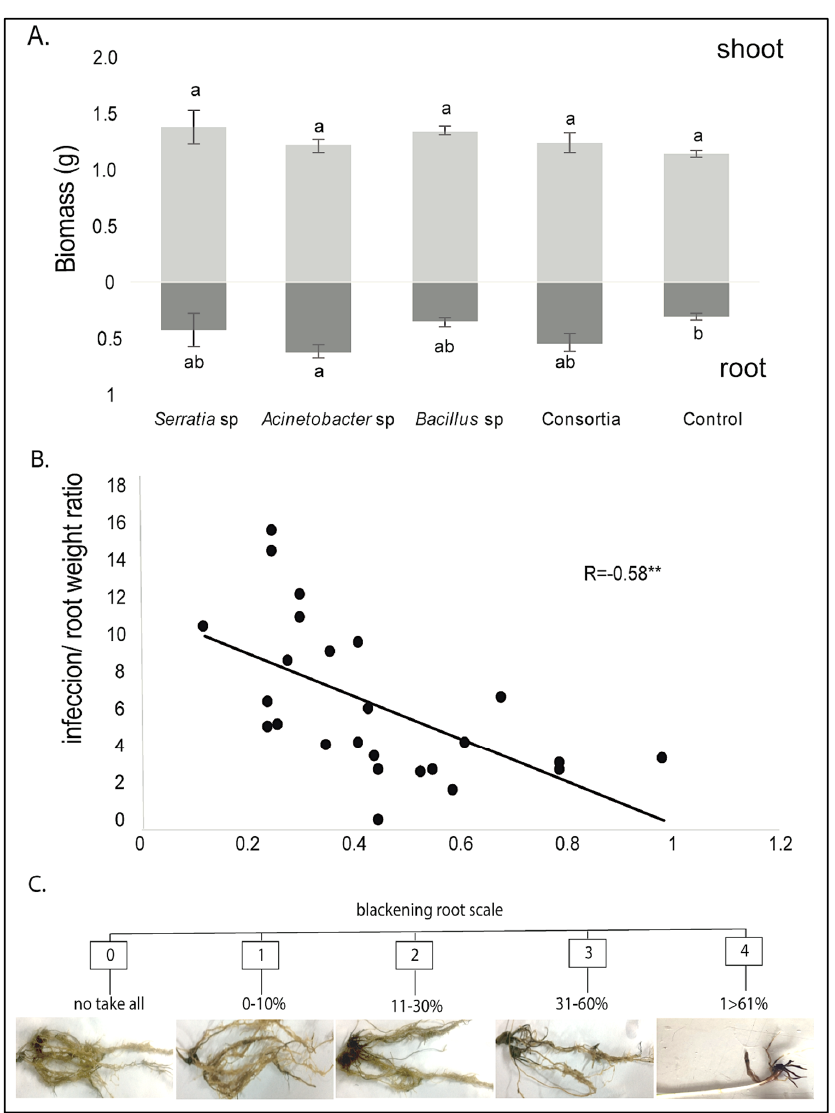
Figure 1. ( A ) Shoot and root biomass (g); ( B ) infection measured by blackening of roots 40 days after inoculation with 1% of Ggt and root biomass ratio; and ( C ) infection scale. Tukey’s test was used to compare treatment means; values followed by the same letter did not differ at p <0.05 ( n = 5). ** Denotes significant differences at p < 0.01. Table 1. The chemical parameters of the Maquehue soil (Freire series).